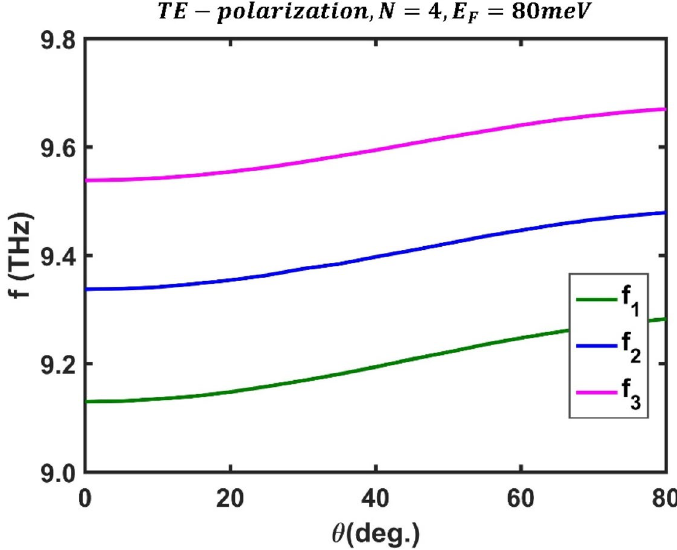
Figure 6. Dependence of central frequency of all three optical channels on the incident angle for TE polarization state at fixed values of E F = 80 meV and N = 4 in third-order F-1D PhC. The central frequencies of all three optical channels shown in green, blue and magenta colors and changes from ( f